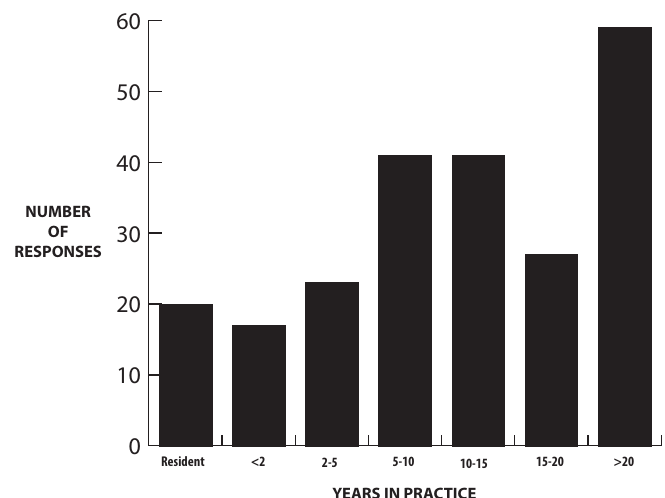
Figure 1. Physician experience by years in